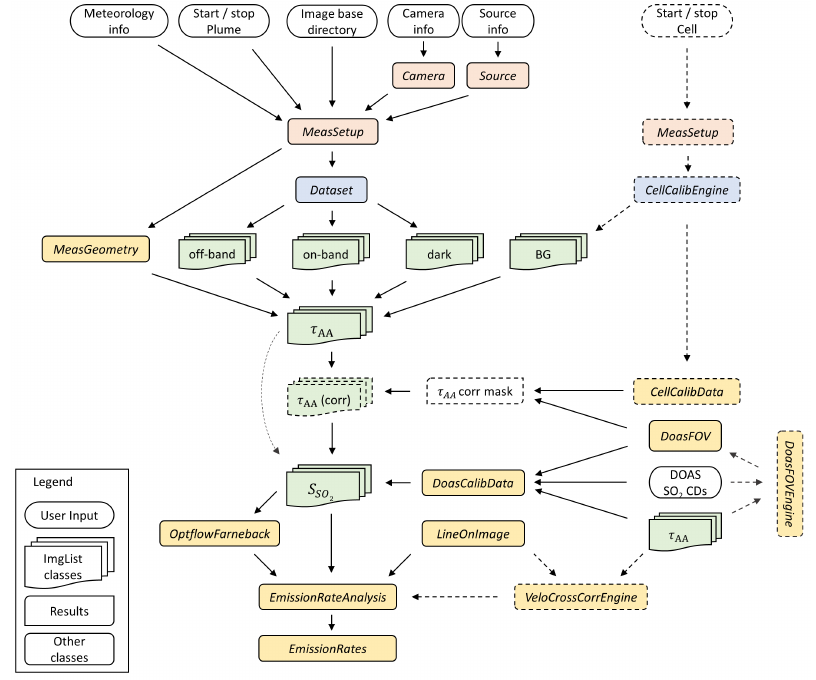
Figure 2. Pyplis API flowchart illustrating the central analysis steps and the corresponding classes of the Pyplis API for SO 2 emission rate retrievals. Italic denotations correspond to class names in Pyplis . Optional/alternative analysis procedures are indicated by dashed boxes. Setup classes (red) include relevant meta information and can be used to create Dataset objects (blue). The latter perform file separation by image type and create ImgList objects (green) for each type (e.g., on, off, dark). Further analysis classes are indicated in yellow. Note that the routine for signal dilution correction is not shown here (cf. Figure